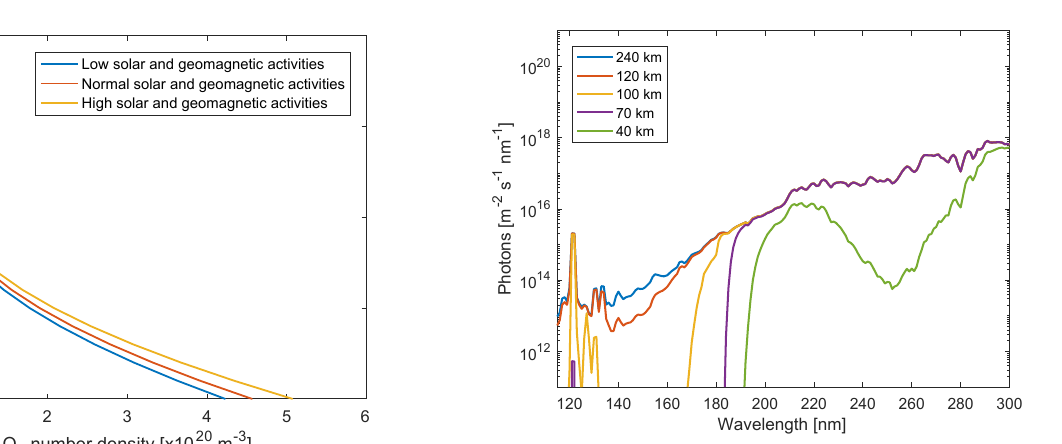
Figure 3. Spectral photon flux from 115 to 300nm for various alti- tudes, for a solar zenith angle θ z of 75 ◦ .